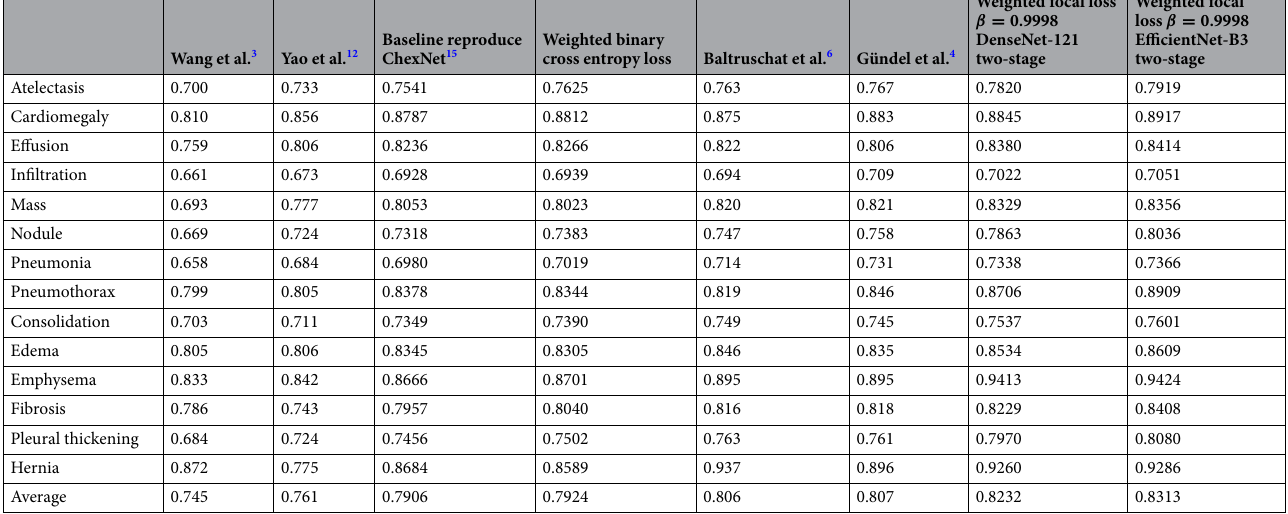
Table 4. Comparison results with previous study under the official